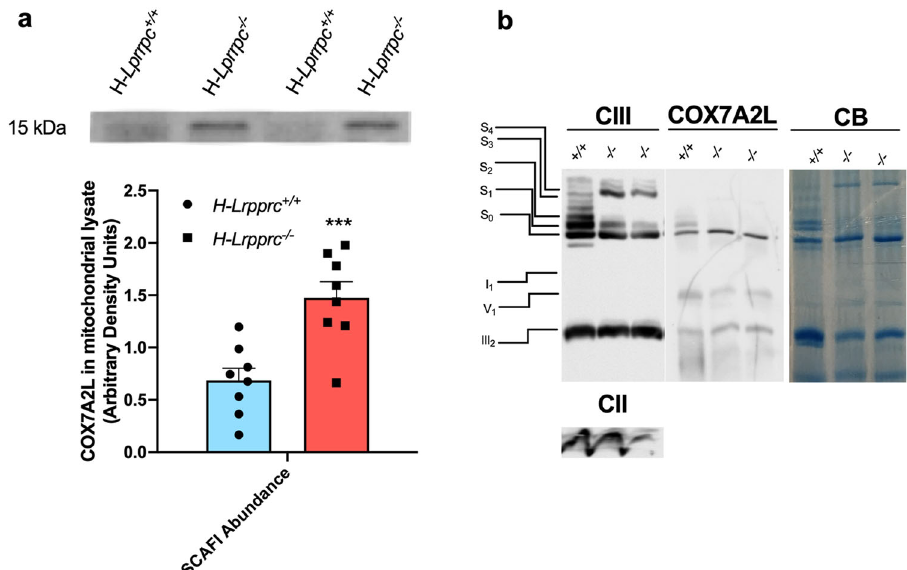
Fig. 3 Impact of LRPPRC de fi ciency on supercomplexes assembly factor SCAF1. a Western blot for quanti fi cation of SCAF1 abundance in liver mitochondria lysate ( n = 8 per group) with a representative image of the blot. (** p < 0.01, Unpaired t -test). b Representative migration pattern of CIV containing arrangements from digitonin solubilized extracts from H-Lrpprc + / + and H-Lrpprc − / − mice resolved by hybrid CN/BN-PAGE ( n = 2 per group). After electrotransfer, one replicate was probed with antibody for CIII and CII, and the other replicate of the same gel with antibody for SCAF1